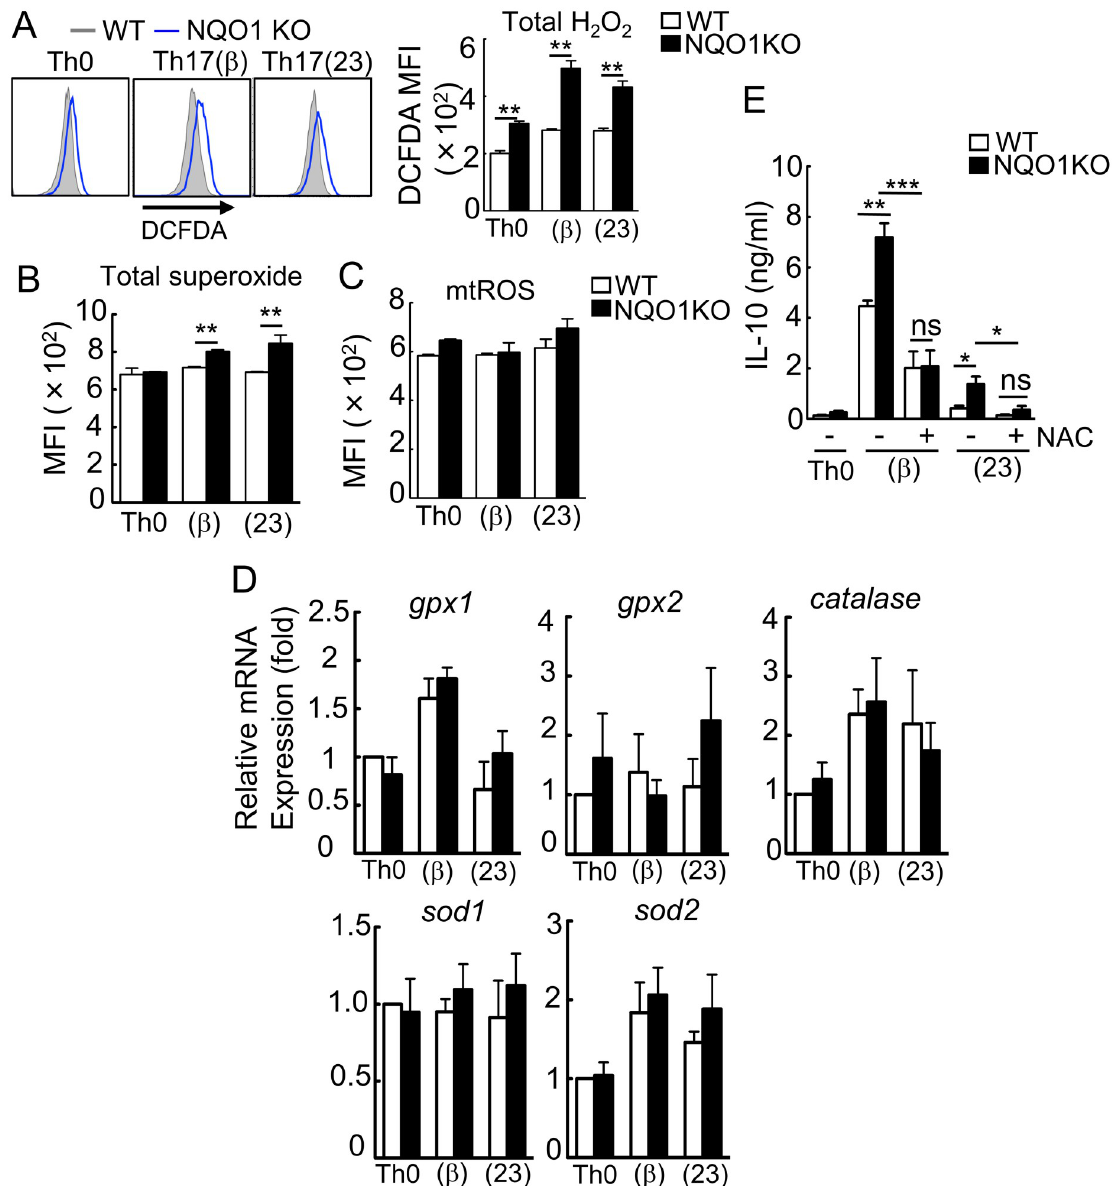
Fig 4. NQO1 inhibits IL-10 production by regulating ROS. (A-C) Na ï ve CD4 + T cells from Nqo1 KO and WT mice were differentiated into Th0, Th17( β ), and Th17(23) cells with the indicated cytokines for 1 day. Cells were loaded with the ROS indicator, DCFDA, DHE, or mtROS detecting reagent and the fluorescence intensities were detected by flow cytometry (n = 3). (D) IL-10 secretion in the cell culture supernatant with or without NAC (5 mM) as measured by ELISA (n = 4). (D) The expressions of a lot of antioxidative enzymes were measured by RT-PCR (n = 4). These graphs indicate the mean ± SE, One way